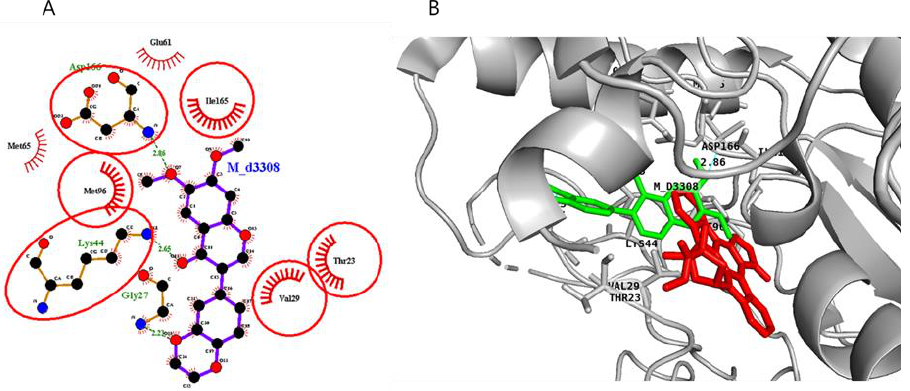
Figure 9. ( A ) The residues participating in the binding sites of the compound 5 -IKK β complex analyzed by using the LigPlot program. ( B ) Three-dimensional image of the IKK β and compound 5 complex, where compound 5 is colored in green and the original ligand K252a contained in IKK β is colored in red.